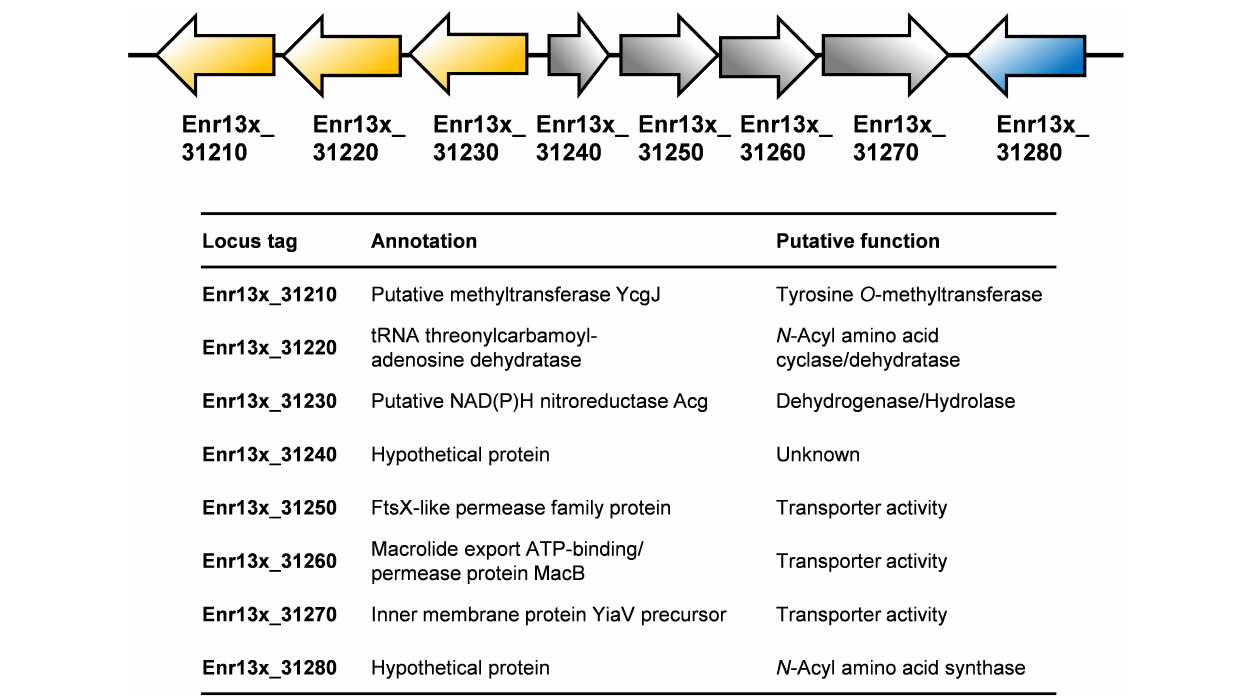
enzymes required for biosynthesis of stieleriacine D are encoded in this